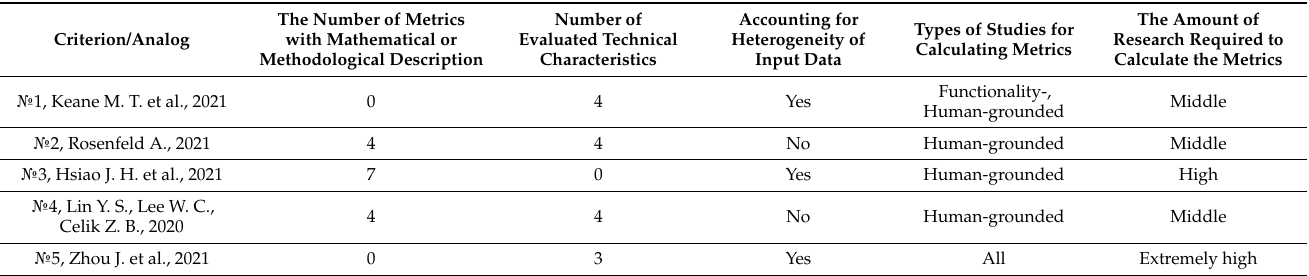
Table 3. Comparison of